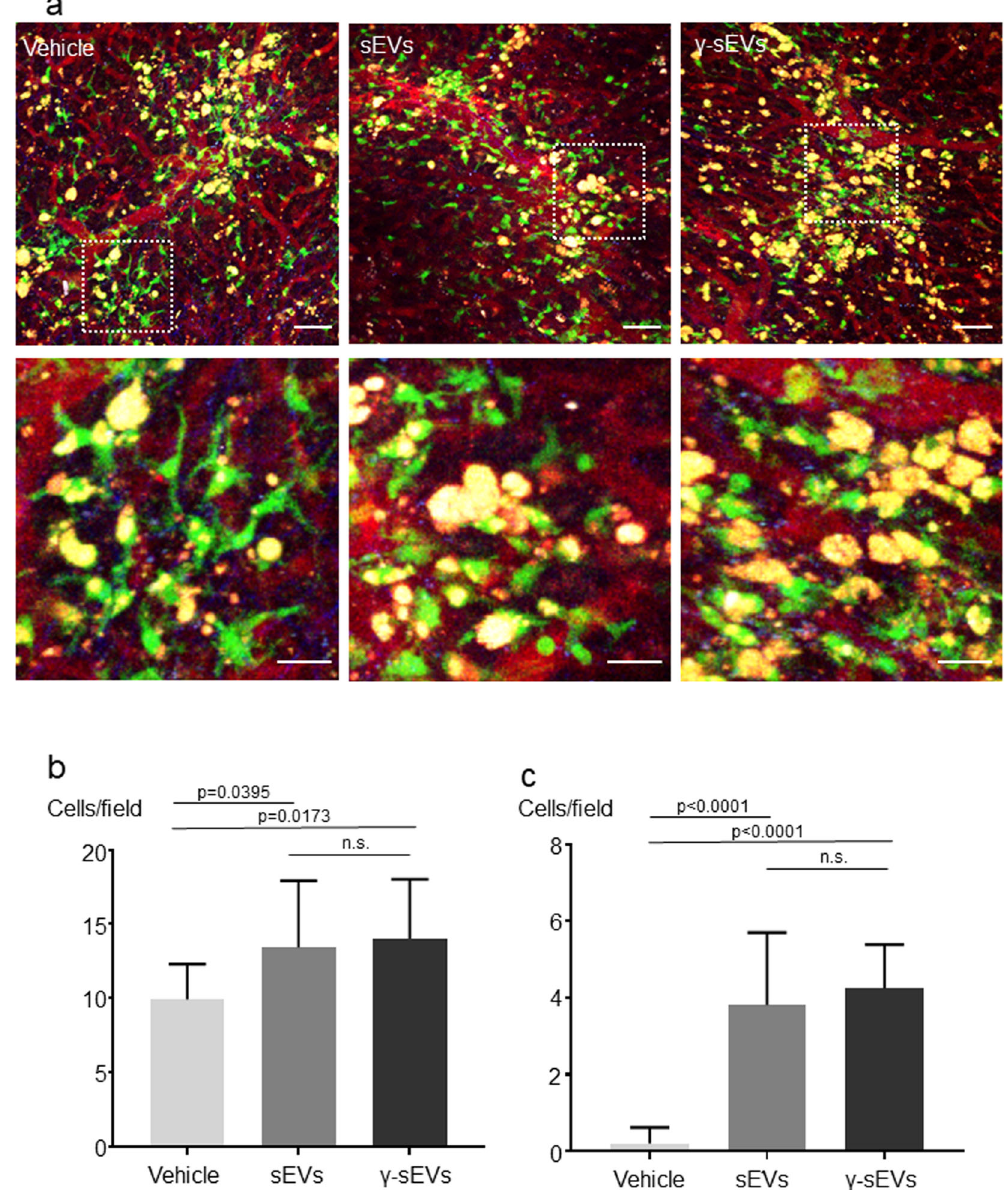
Fig. 5 Intravital imaging after administering AD-MSC-sEVs (sEVs) or AD-MSC- γ -sEVs ( γ -sEVs) in CCl4-damaged CX 3 CR1-EGFP mice. a Representative images 24 h after injecting the vehicle, sEVs, and γ -sEVs; scale bar = 50 μ m (upper panels) and 20 μ m (lower panels). (Supplementary Movie 3; vehicle, sEVs, and γ -sEVs from left to right in order). Lower panels: magni fi ed view of upper panels. b Numbers of CX 3 CR1 + GFP-expressing cells gathering with or surrounding the hepatocyte debris. Data are presented as means ± SD; n = 10 – 11 per experiment. c Numbers of CX 3 CR1 + GFP-expressing cells migrating into the damaged area. Data are presented as means ± SD; n = 10 – 12 in each